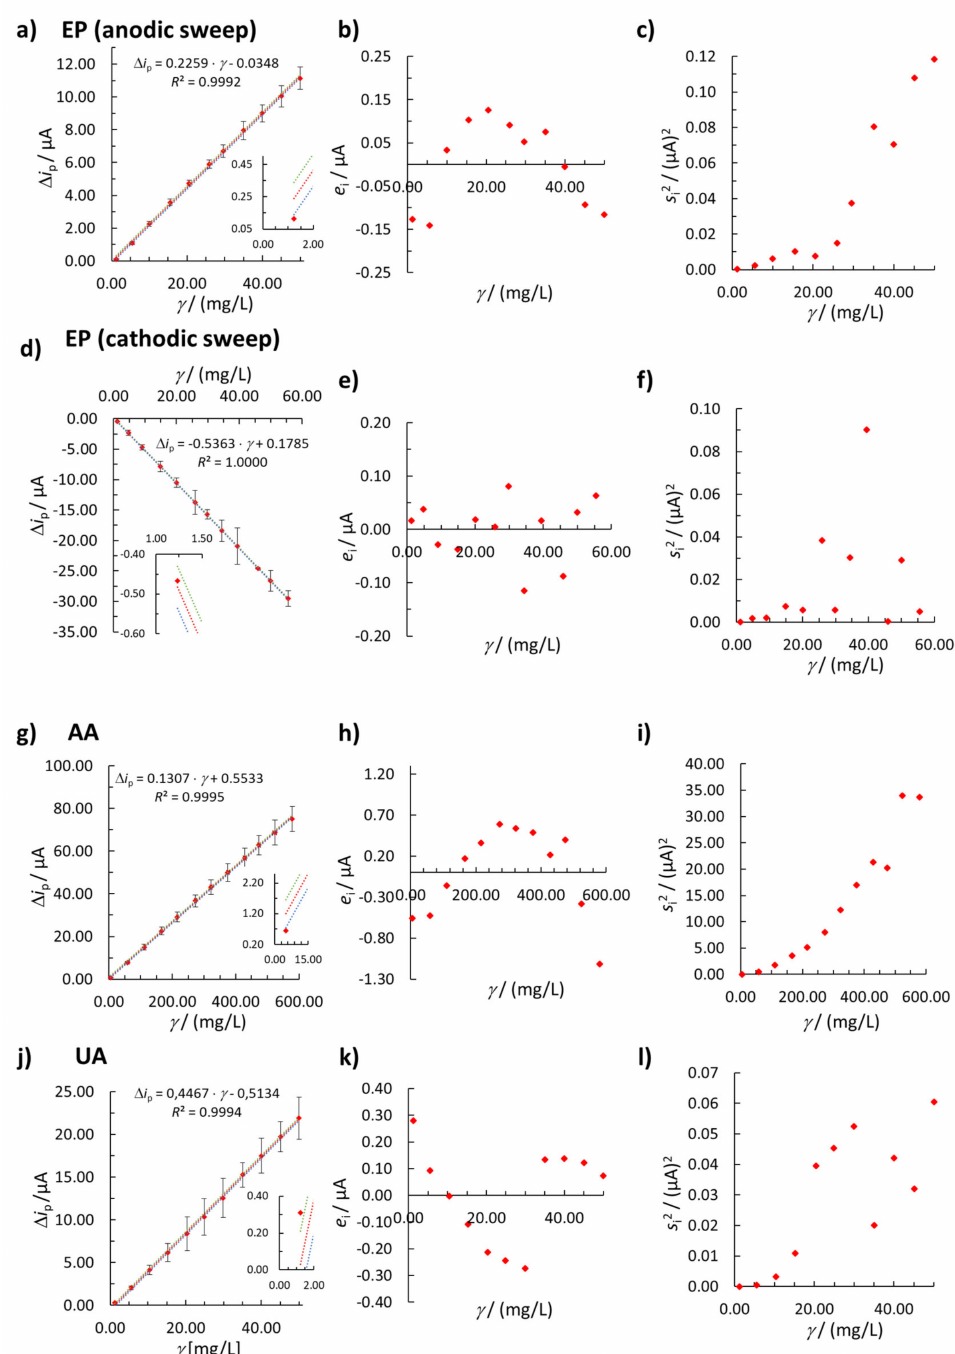
Figure 2. Linear concentration ranges for ( a ) EP (anodic sweep), ( d ) EP (cathodic sweep), ( g ) AA, and ( j ) UA (the error bars in Figure 2a,d,g,j represent standard deviations–for better visual representation, the standard deviation values for EP (anodic sweep) were multiplied by a factor 2, while the standard deviation values for EP (cathodic sweep) and UA were multiplied by a factor of 10, whereas no multiplication was performed for AA). The insert in Figure 2a,d,g,j shows the first calibration point of the linear concentration range, and the dotted curves represent 95% confidence intervals (upper range green and lower range blue). The plots of residuals vs. concentration are shown in ( b ) for EP (anodic sweep), ( e ) for EP (cathodic sweep), ( h ) for AA, and ( k ) for UA. Plots of variance vs. concentration are shown for ( c ) EP (anodic sweep), ( f ) EP (cathodic sweep), ( i ) AA, and ( l )